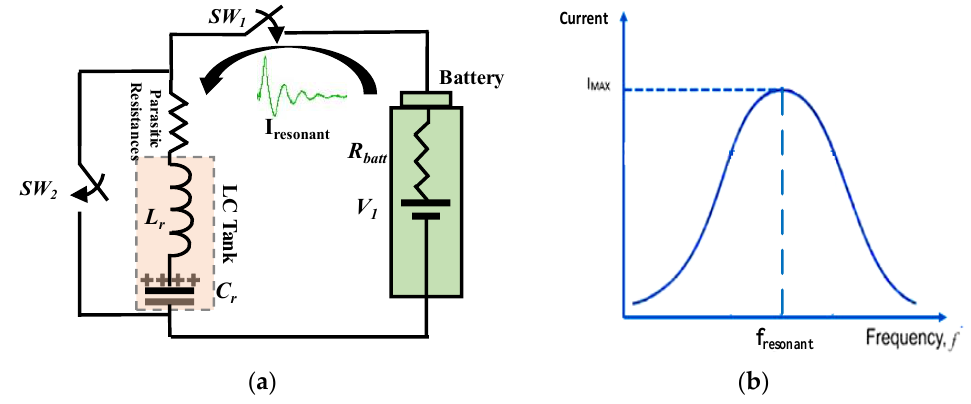
Figure 3. ( a ) Series LC resonant with battery; ( b ) current peak at resonant frequency.